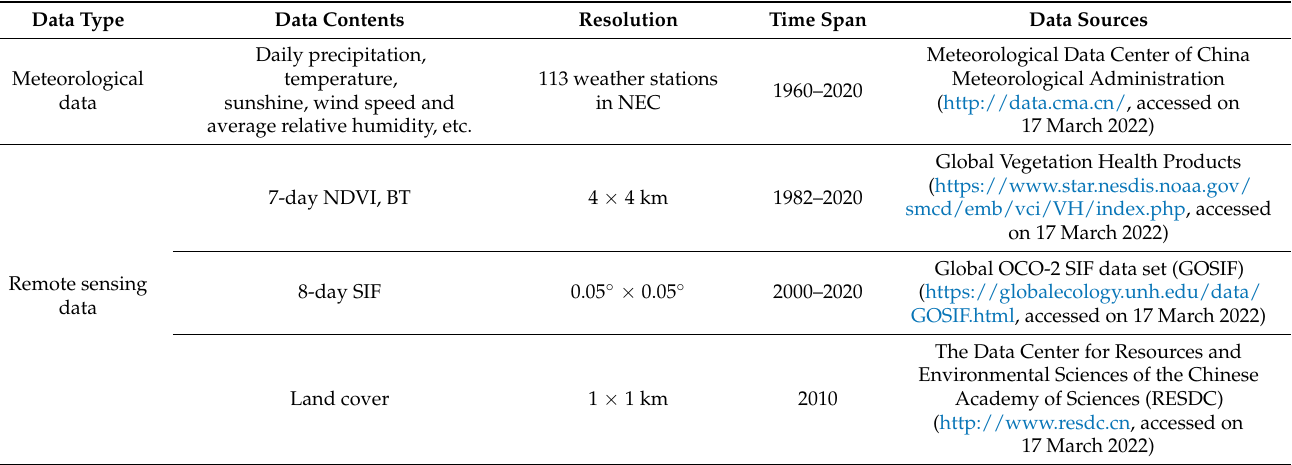
Table 1. Data types and